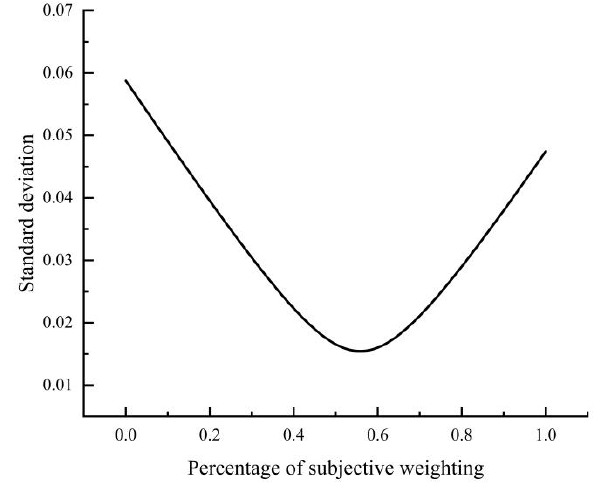
Figure 8. Variation of standard deviation with weight coefficient of W 1 . Table 3. Weights of indicators for the vulnerability